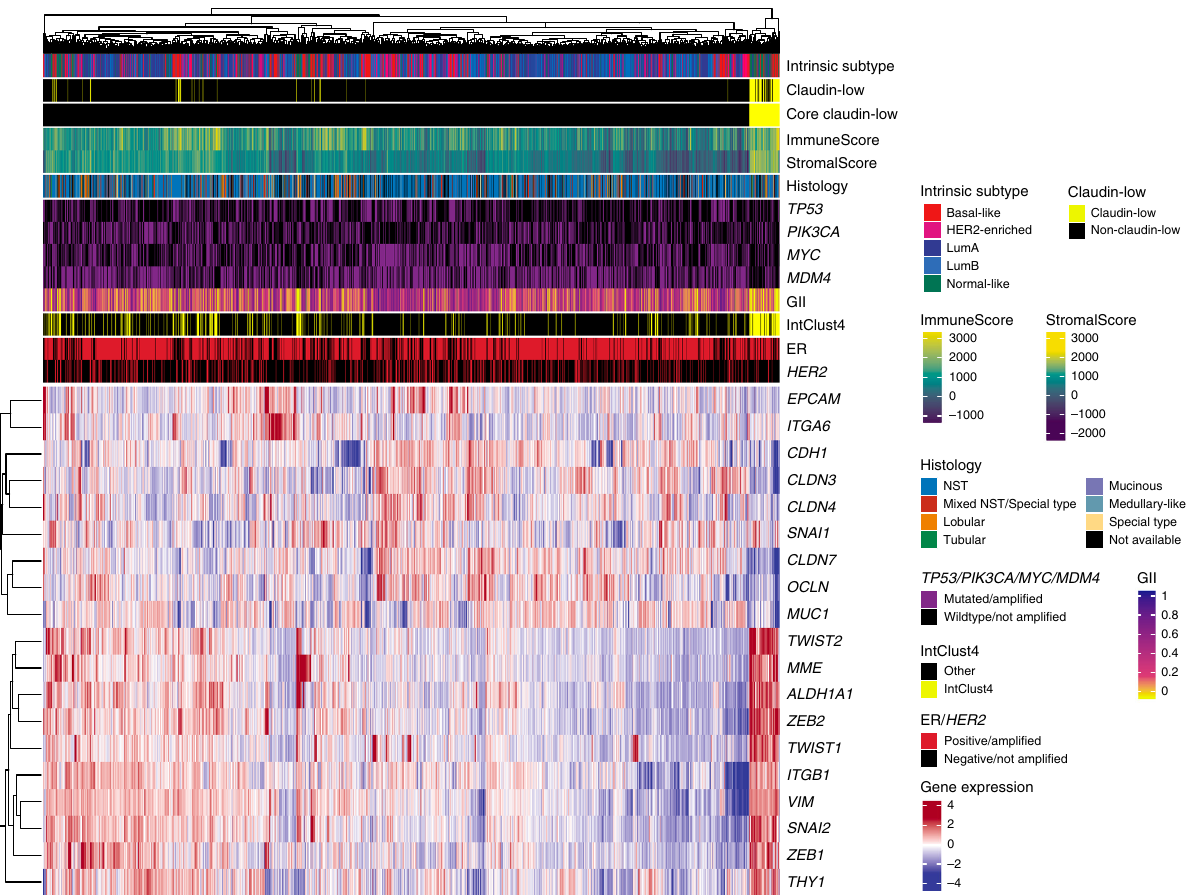
Fig. 3 A condensed claudin-low gene list identi fi es a set of core claudin-low tumors. Heatmap of gene expression values (log2) for a condensed claudin- low gene list in the METABRIC cohort ( n = 1886 biologically independent samples). A cluster, marked Core claudin-low ( n = 79), emerged with transcriptomic and genomic claudin-low characteristics ( P = 0.006, SigClust 22 ). Source data are provided as a Source Data fi